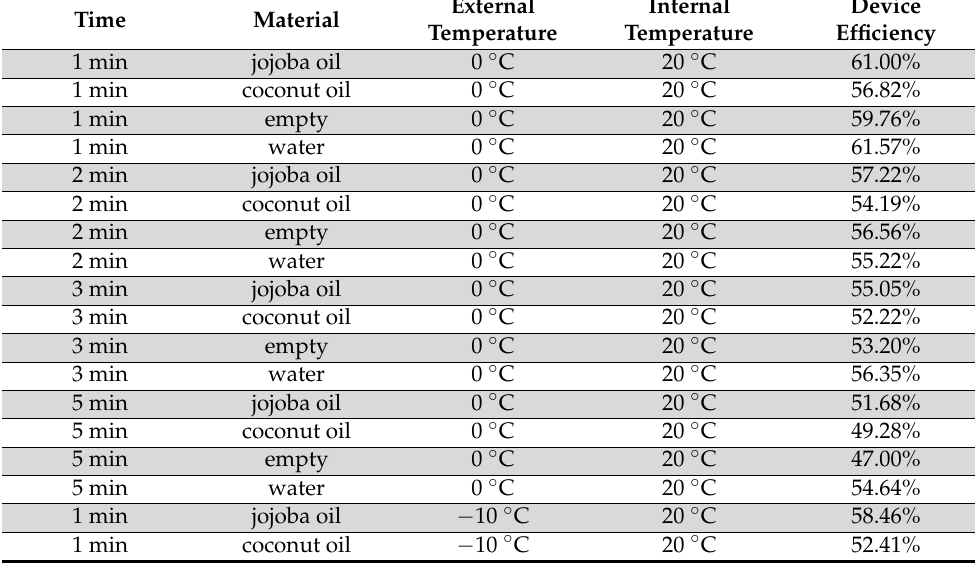
Table 6. Unit efficiency with heat exchanger